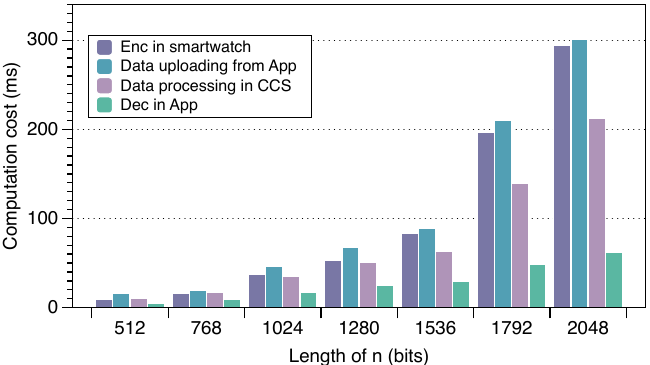
Figure 6. The time spent on data transmission and data